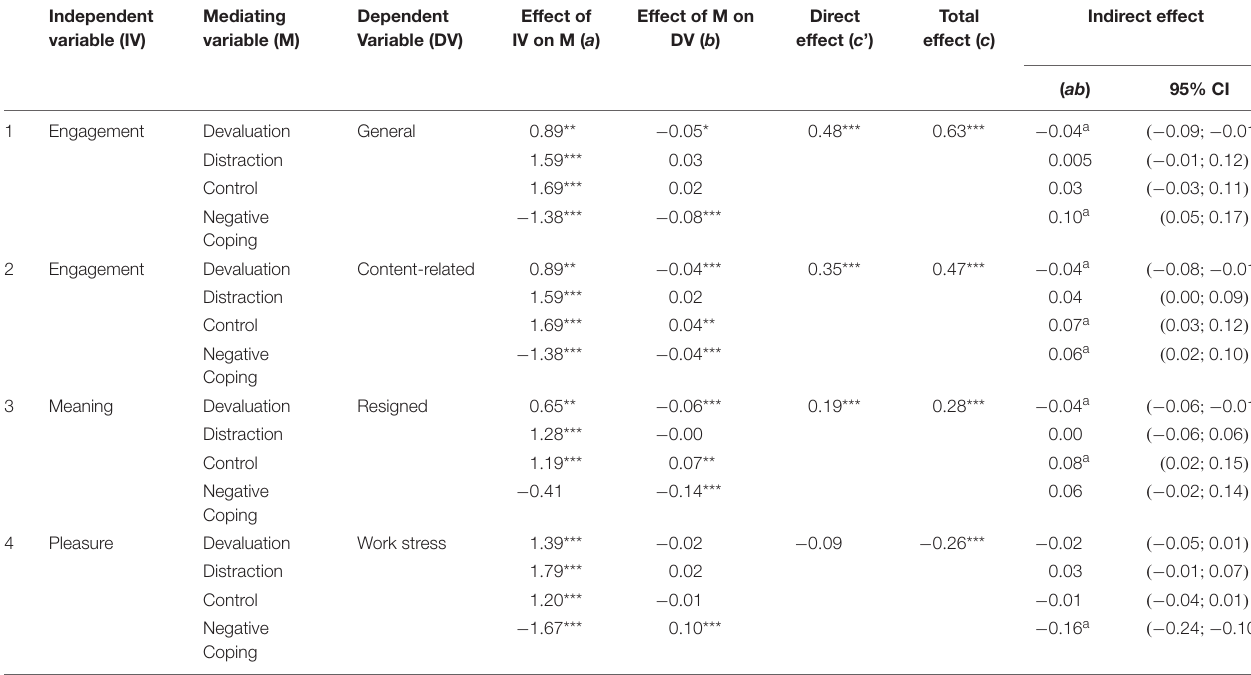
TABLE 4 | Parallel mediation analyses predicting types of work satisfaction and work stress (DV) (10,000 bootstrap samples). Independent Mediating variable (IV) variable (M)